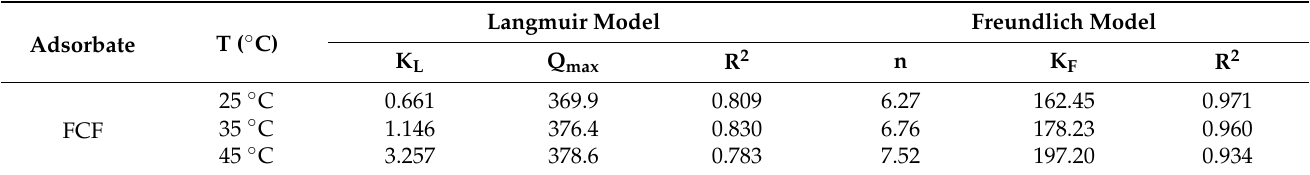
Table 3. Adsorption isotherm parameters at different temperatures.